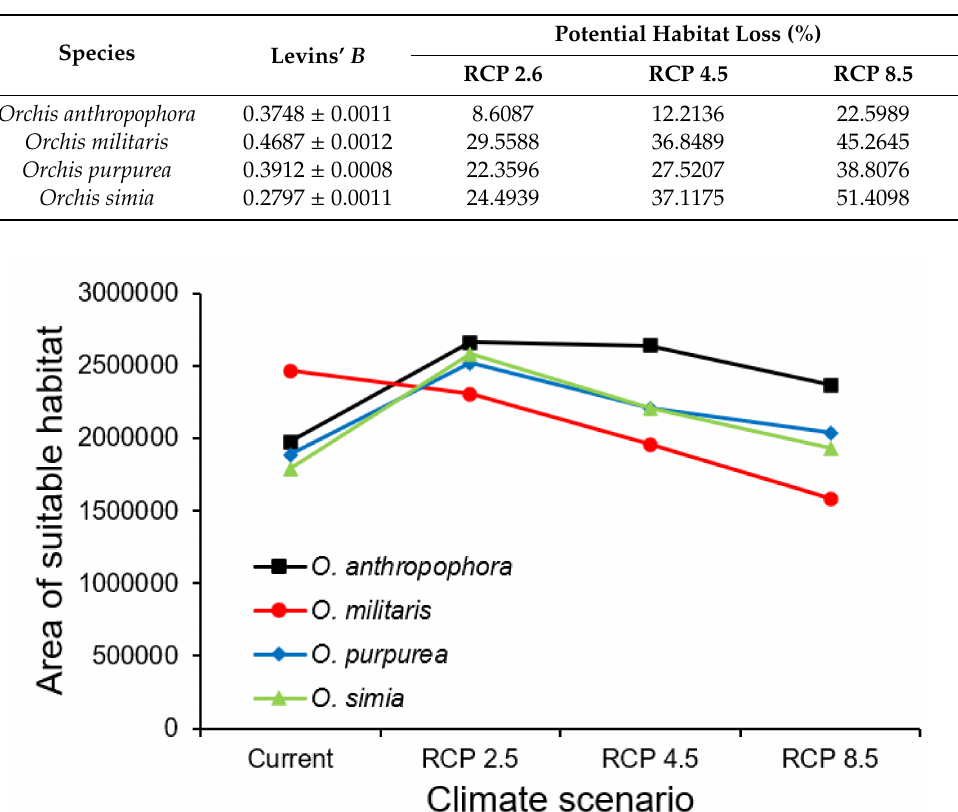
Table 1. Levins’ B value (niche breadth) and current area of suitable habitat (km 2 ) predicted for four Orchis species, as well as the potential habitat loss expected for 2050 if the species are unable to disperse into new areas with the same habitat characteristics as are currently occupied.